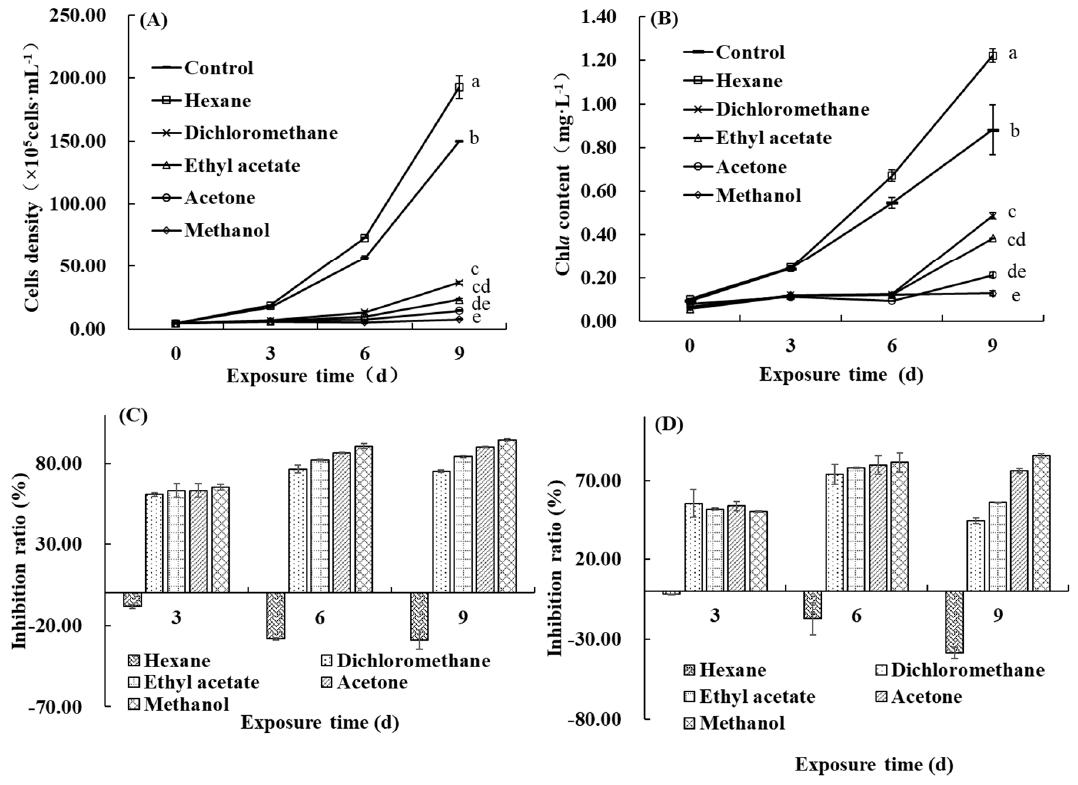
Figure 5. Cell density ( A ) and chl a content ( B ) of M. aeruginosa treated with the eluting fractions of SPE-enriched aqueous extracts from D. indicum flowers at 2.0 g · DW · L − 1 and the corresponding inhibition ratio based on cell density ( C ) and chl a content ( D ) in a 9-day bioassay. Different letters indicate significant differences among different groups at p < 0.05 level.